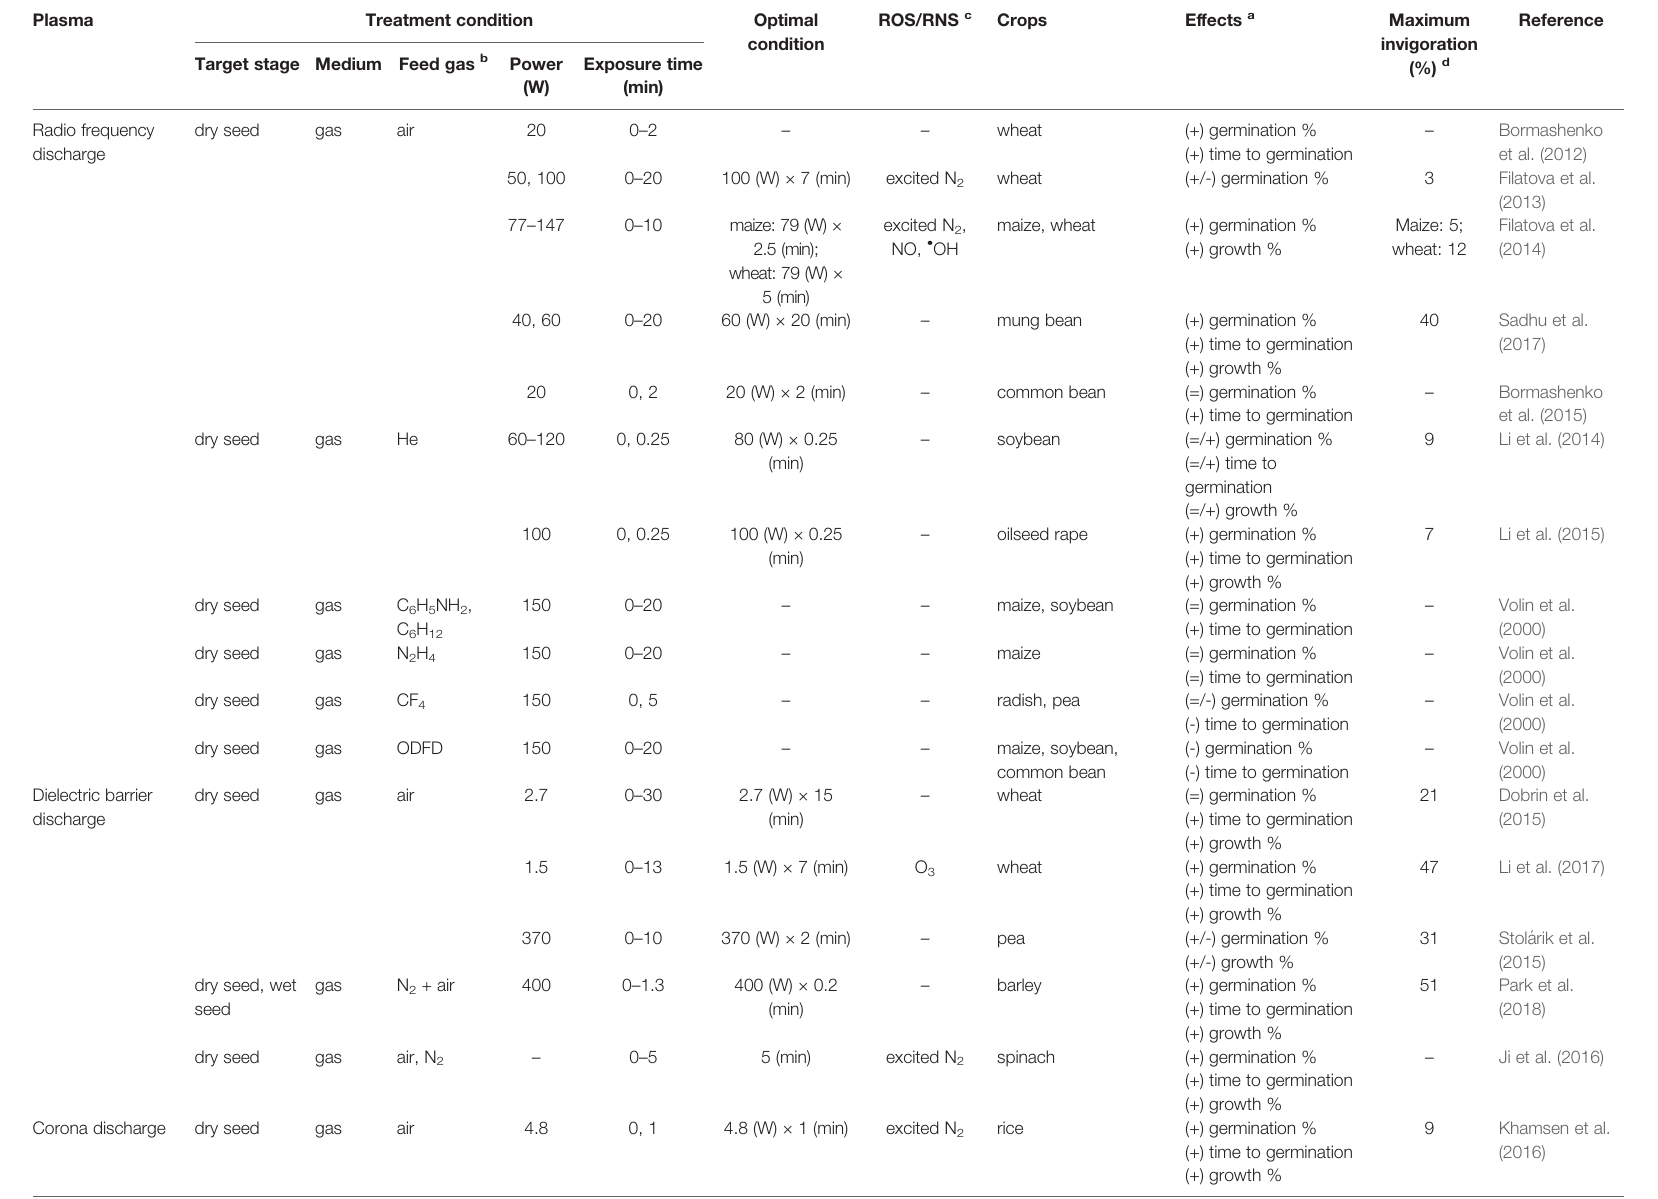
TABLE 1 | The scari fi cation effects of the plasma treatments on seeds from a wide range of crops, including cereals, legumes, and